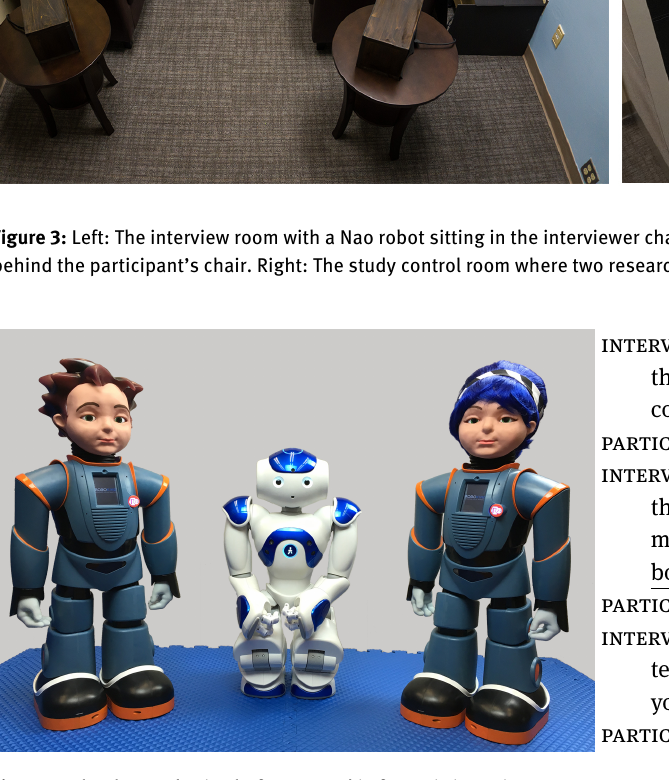
Figure 4: The three robotic platforms used in forensic interviews (RoboKind R25 robots left and right, Nao robot